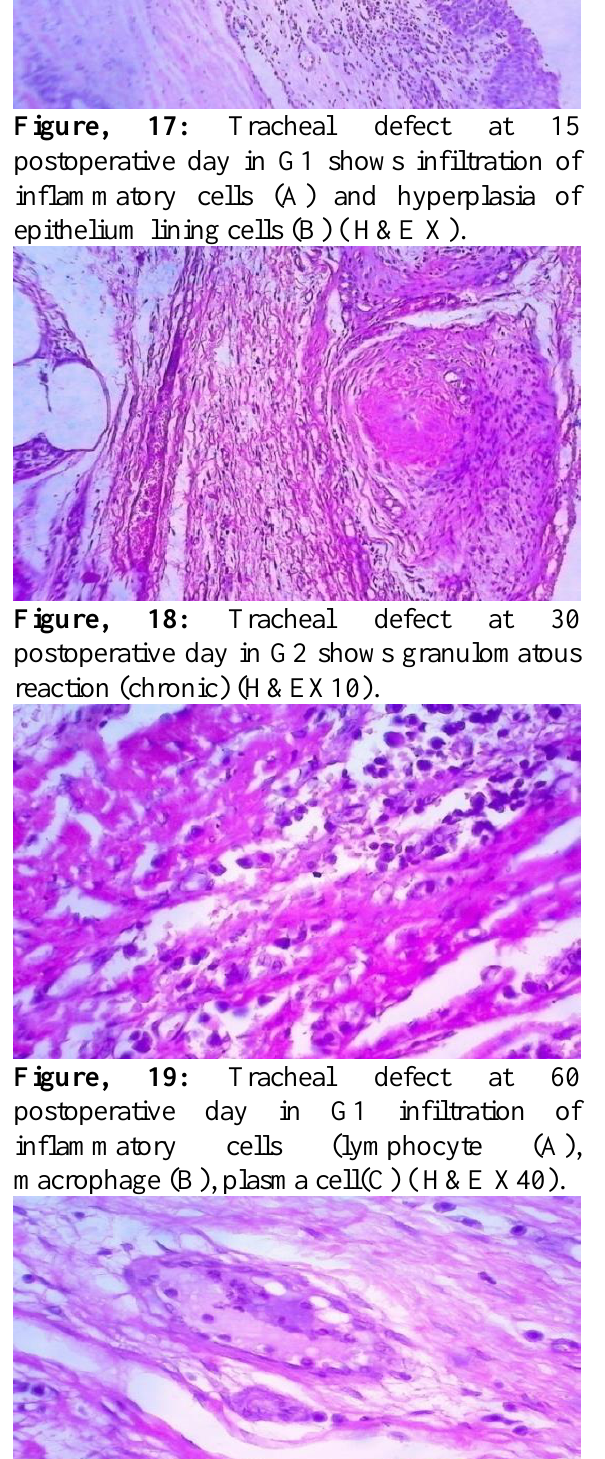
Figure, 24: Tracheal defect at 30 postoperative day in G2 shows new cartilage tissue formation (A) (